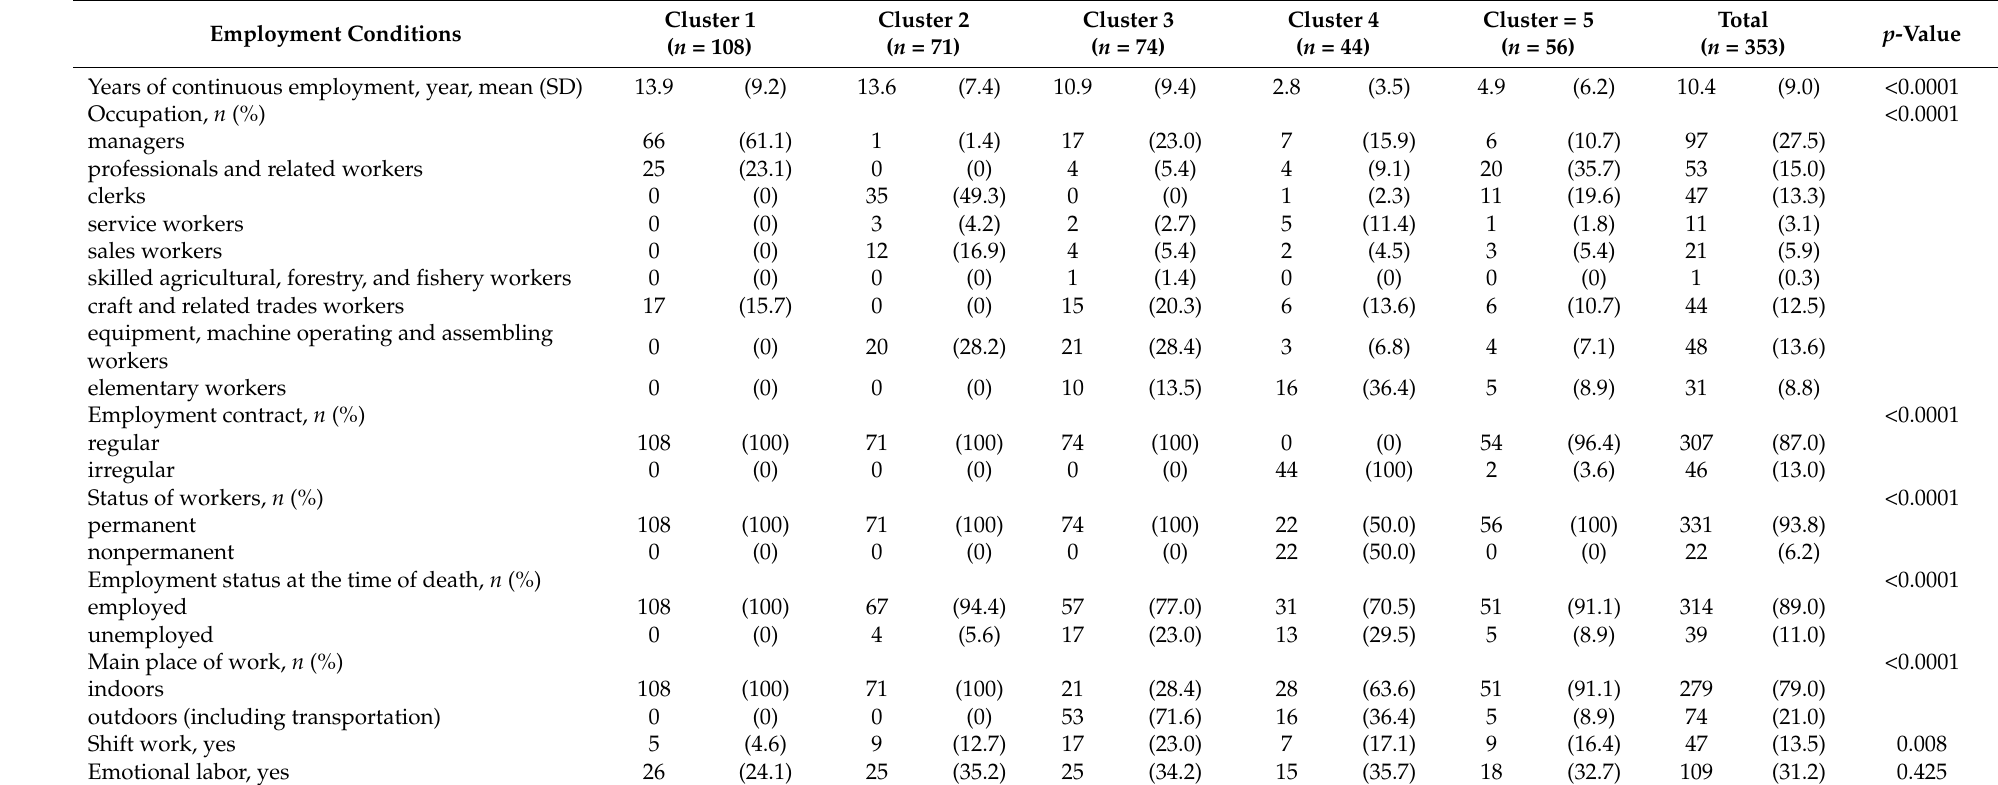
Table 2. Comparison of employment conditions for five clusters of worker suicide